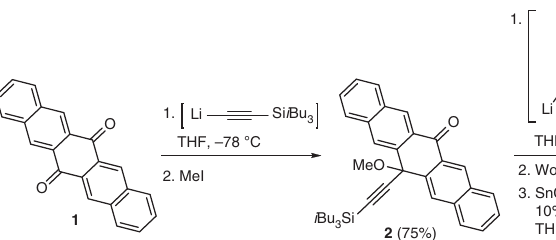
NATURE COMMUNICATIONS|8:15171|DOI: